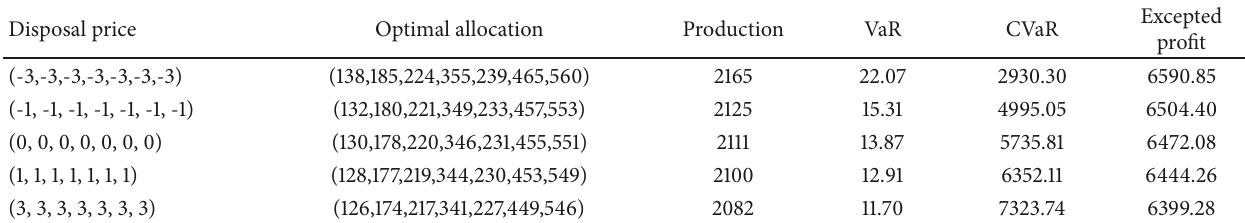
Table 1: Allocation, VaR, CVaR, and t he excepted profit of chain stores in decentralized supply ( 𝜆 = 0 ). Disposal price Optimal allocation